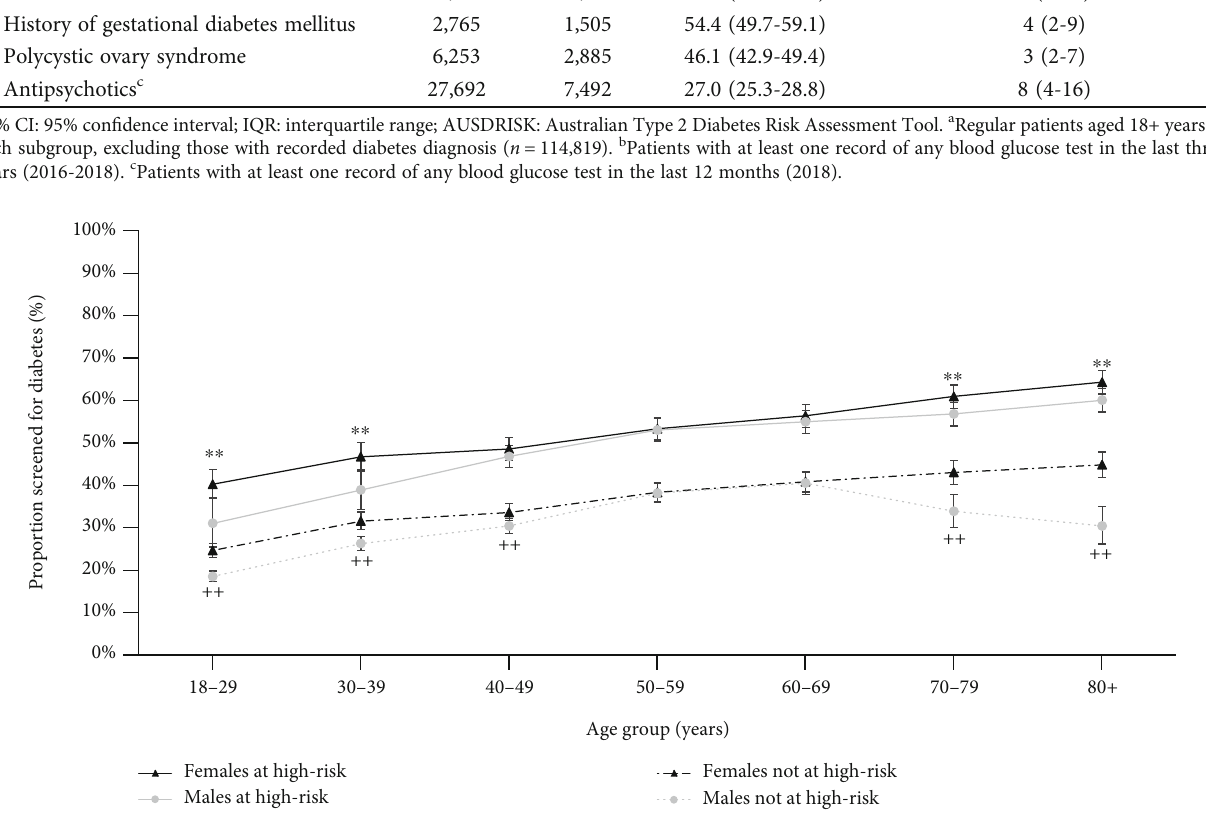
Figure 3: Prevalence of having a record of diabetes screening in males and females according to age and presence or not of risk factors for diabetes. P value for the di ff erence between males and females at high risk: ∗ < 0.01 and ∗∗ < 0.001; P value for the di ff erence between males and females not at high risk: + < 0.01 and ++ <